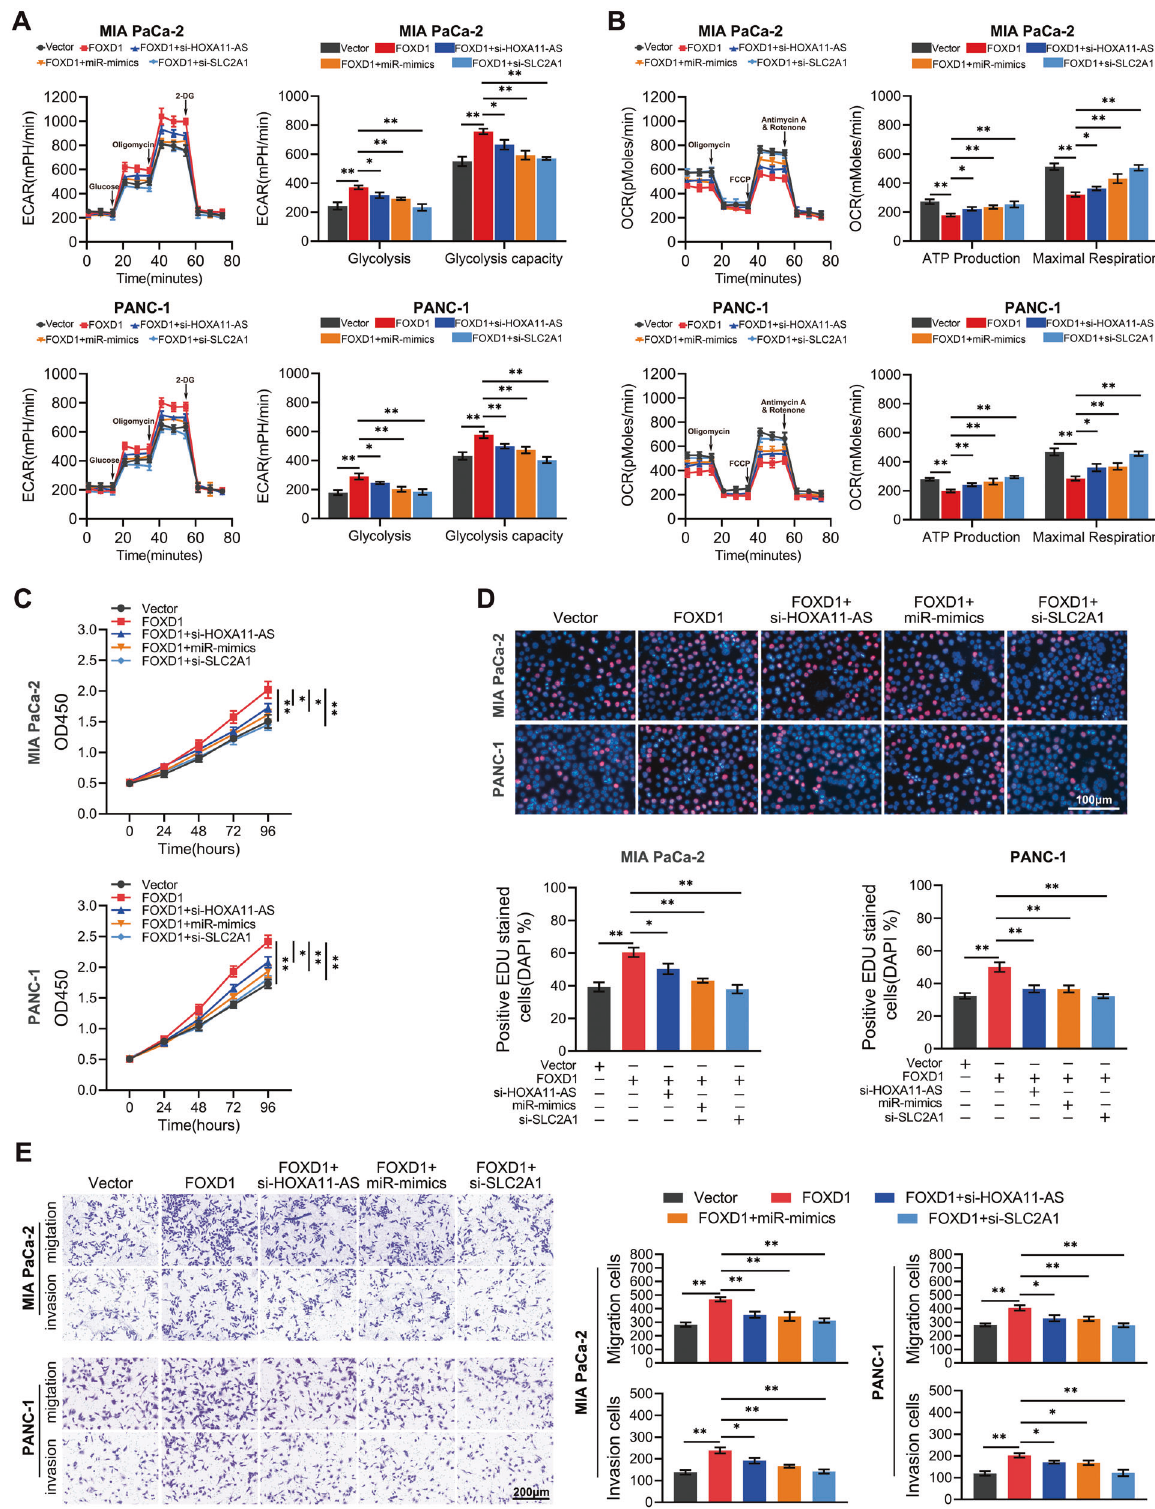
Fig. 6 The HOXA11-AS/miR-148b-3p/SLC2A1 axis is essential for FOXD1-mediated PC progression. PC cells infected with FOXD1- overexpressing lentivirus were co-transfect with si-HOXA11-AS, miR-148b-3p mimics, and si-SLC2A1. A , B ECAR and OCR were employed to measure the level of aerobic glycolysis in each group. C , D CCK8 and EdU staining were employed to evaluate the proliferation capacity. E Transwell assays were performed to evaluate the invasive and metastatic capacities. * p < 0.05; ** p <